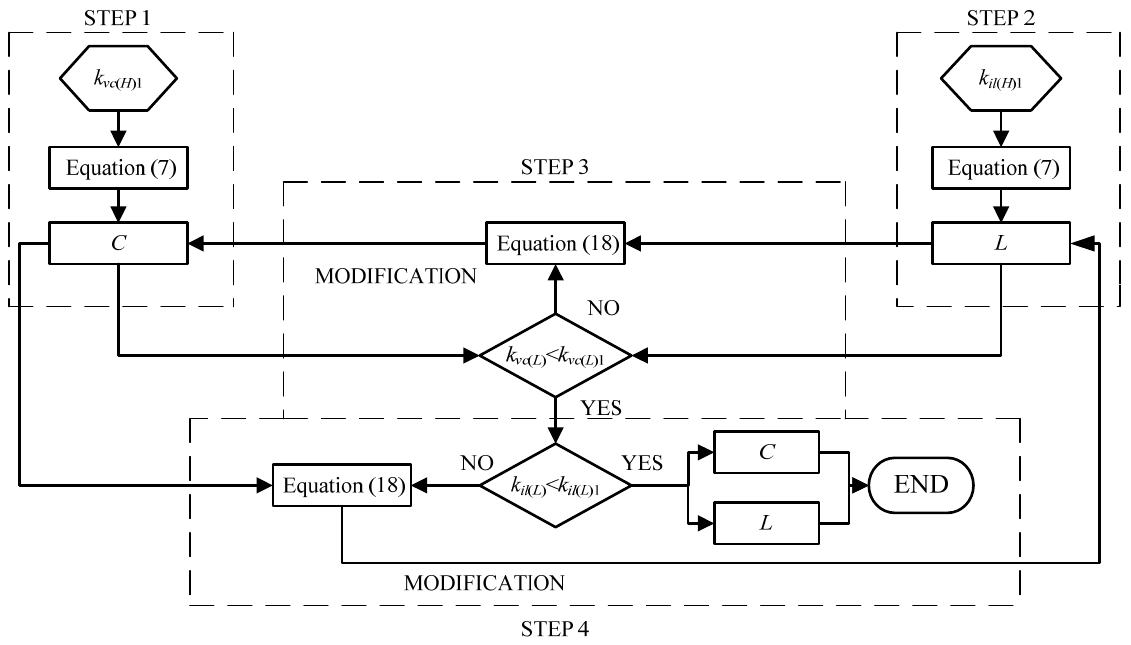
Figure 6. Detailed design procedure of a Z-Source